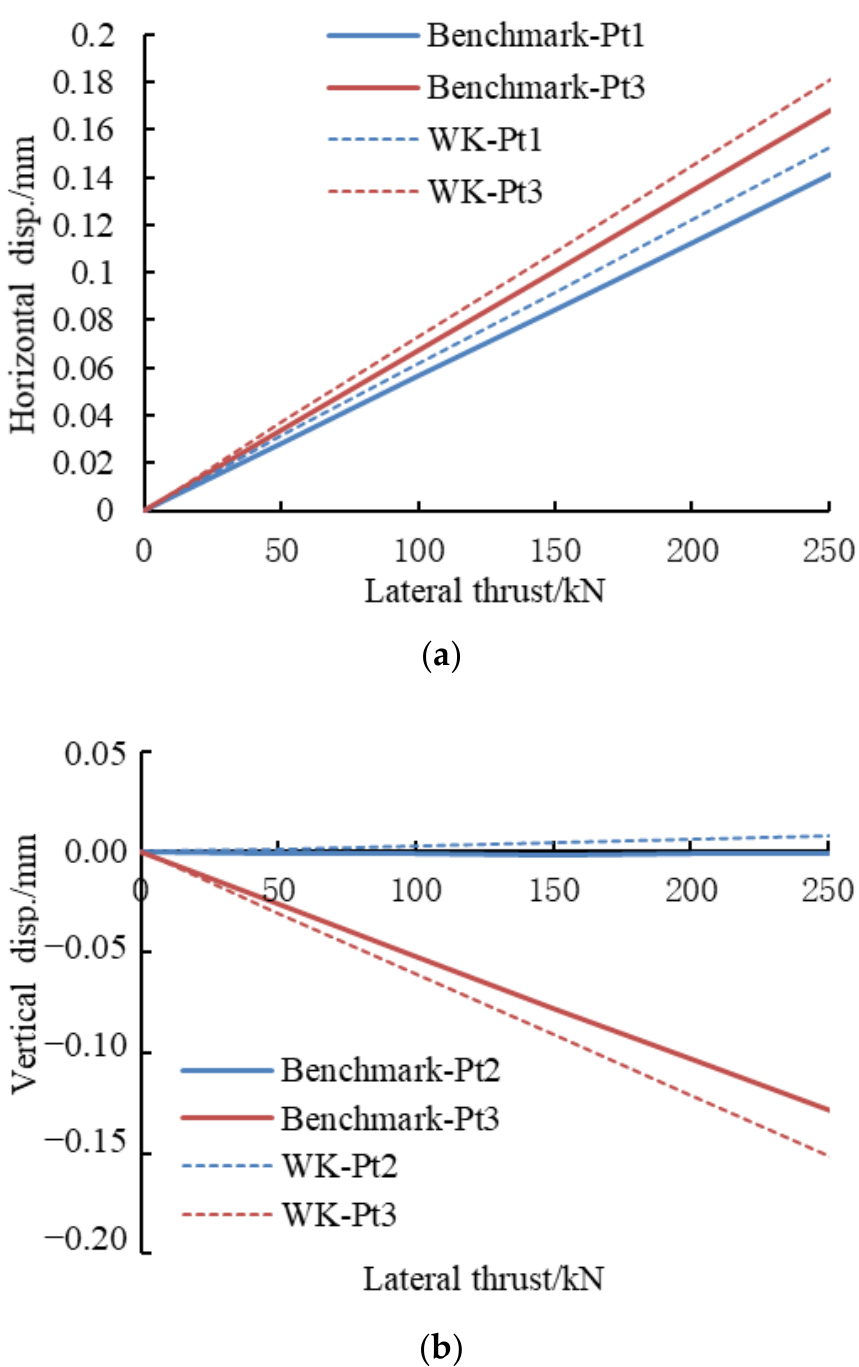
Figure 22. Comparison of DEM predicted displacements with/without anti-slip measures at the initial loading phase. ( a ) Horizontal displacement; ( b ) Vertical displacement.